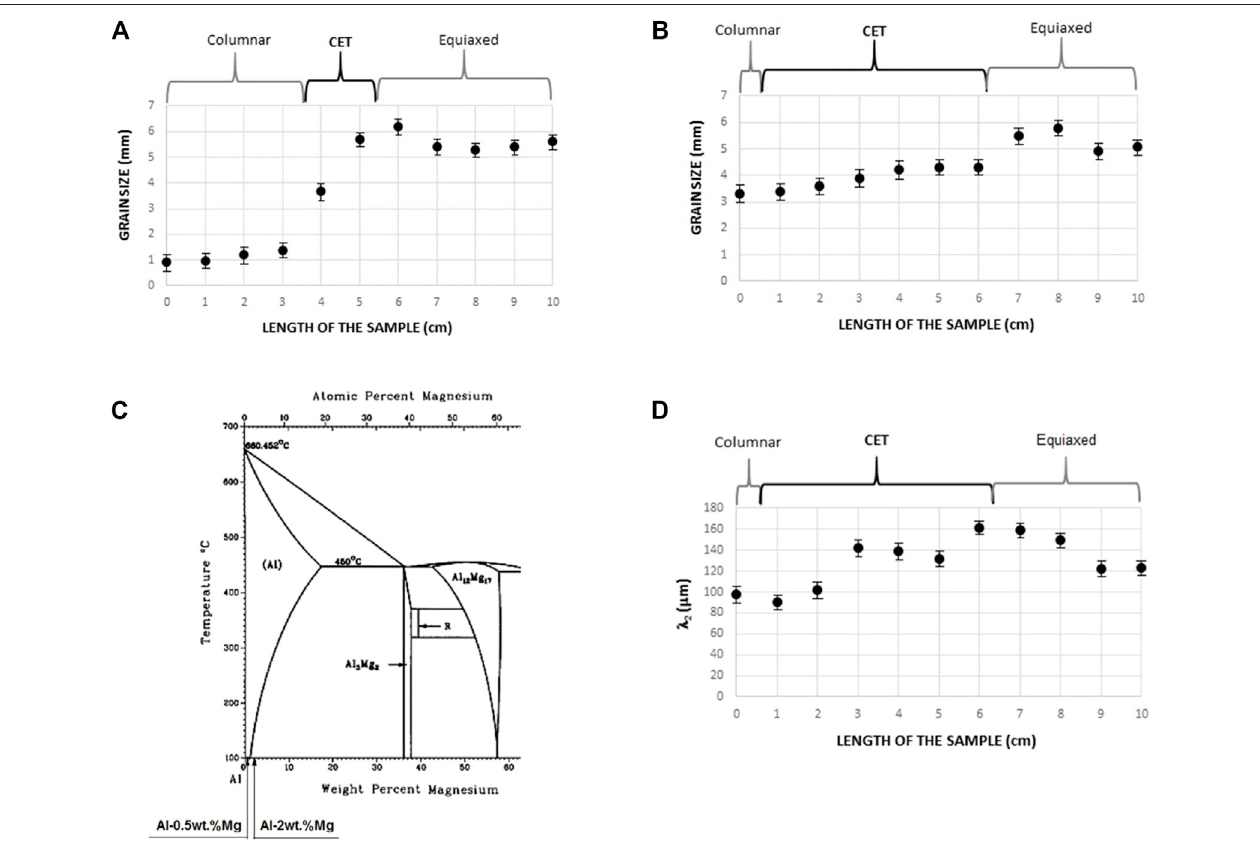
FIGURE4| Grainsizeasafunctionofthelengthofthesample. (A) Al-0.5wt.%Mg. (B) Al-2wt.%Mg. (C) Al-Mgphasediagram(ontheAlside)showingthepositions of the Al-0.5wt.%Mg and Al-2wt.%Mgalloys (adapted from Boyer and Gall, 1990). (D) Secondary dendritic arm spacing, λ 2 , as afunction ofthe length of the sample for Al-2wt.%Mg